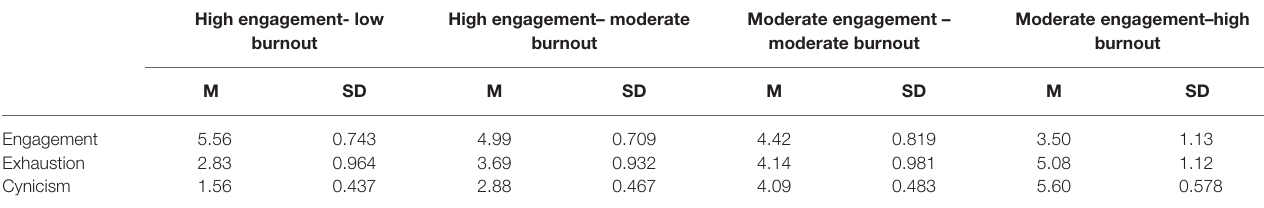
TABLE 3 | Profile means and standard